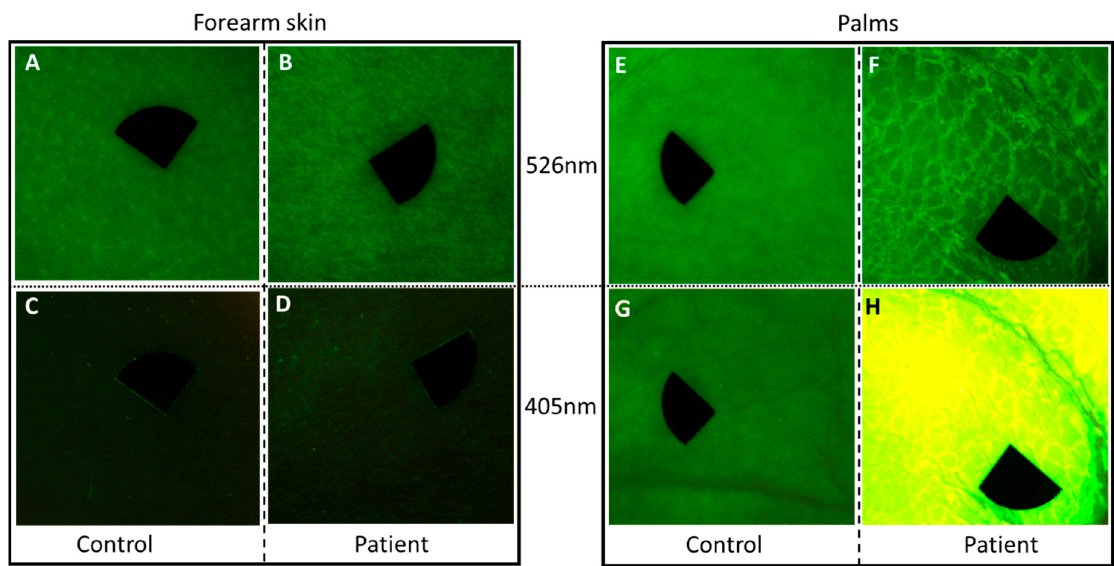
Figure 4. Diffuse reflectance images of the patient and an age-matched healthy individual at 526 nm ( A , B , E , F ) and autofluorescence under 405 nm light emitting diode (LED) excitation ( C , D , G , H ). ( A – D ) Clear skin area on the forearm of the patient and the healthy control with the endogenous autofluorescence of the skin; ( E – H ) palmar skin; ( F ) the edges of the thick squames were defined at 526 nm illumination on the patient; ( H ) the thick hyperkeratotic layer on the palm gave a strong autofluorescence signal at 405 nm excitation. The size of the images is 2 × 2 cm 2 . Black markers do not point to areas of interest, but are used for image alignment. Pixel size: 180 pixels/cm.